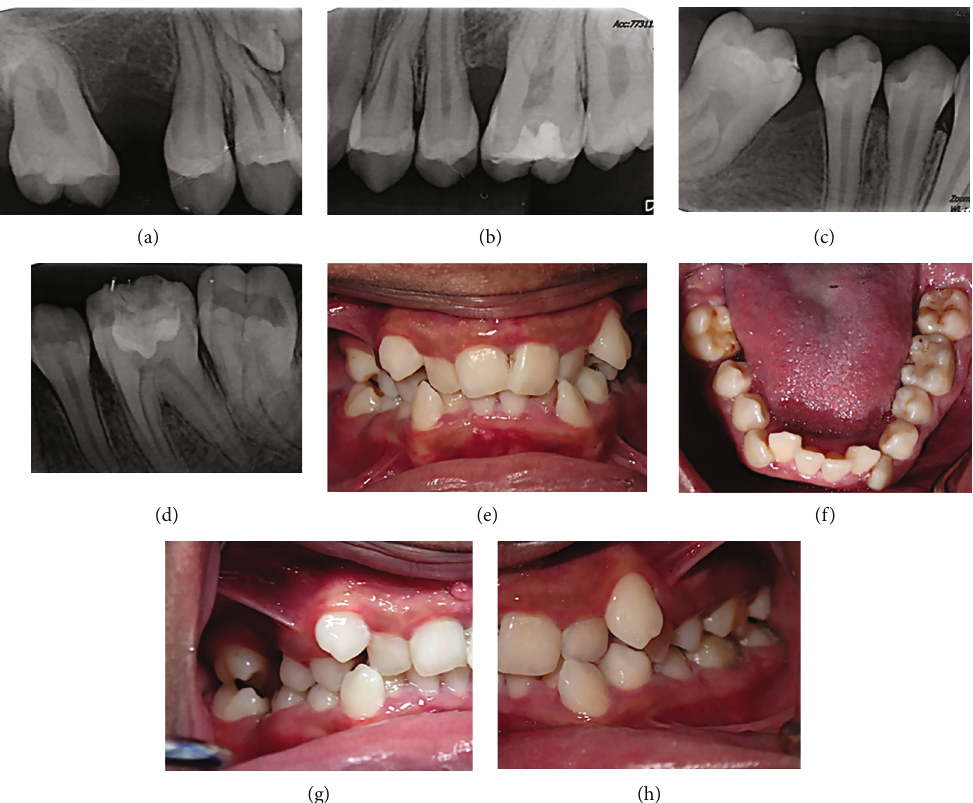
Figure 3: Periapical radiographs and intra-oral images taken at 6 months recall from second excisional biopsy (no recurrence was observed up to 12